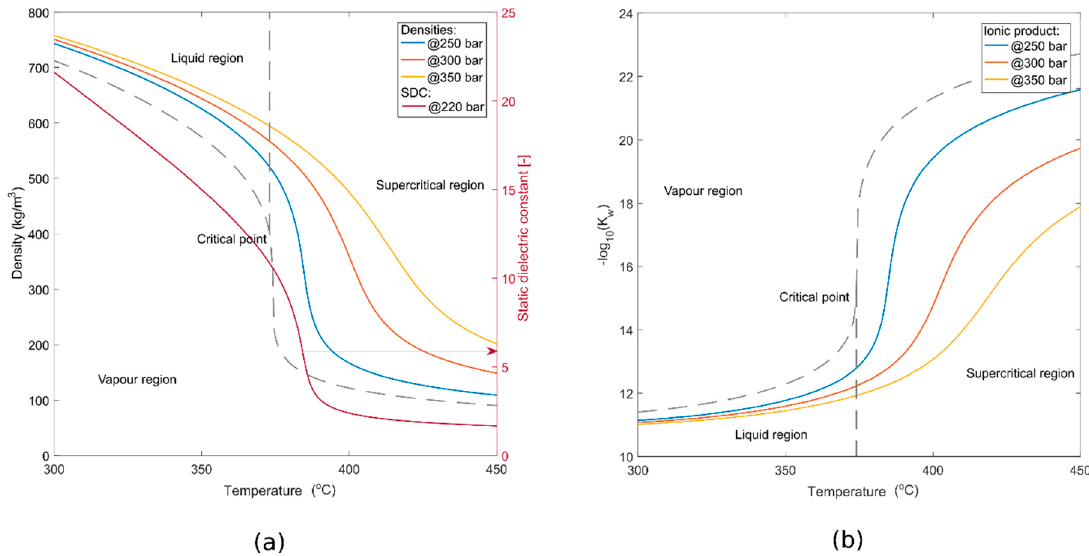
Figure 1. Thermophysical properties of water. In both plots, the grey dashed line is the saturation curve. ( a ) Density and dielectric constant as a function of temperature; ( b ) Ionic product as a function of temperature near the critical point. Data from [29–31].